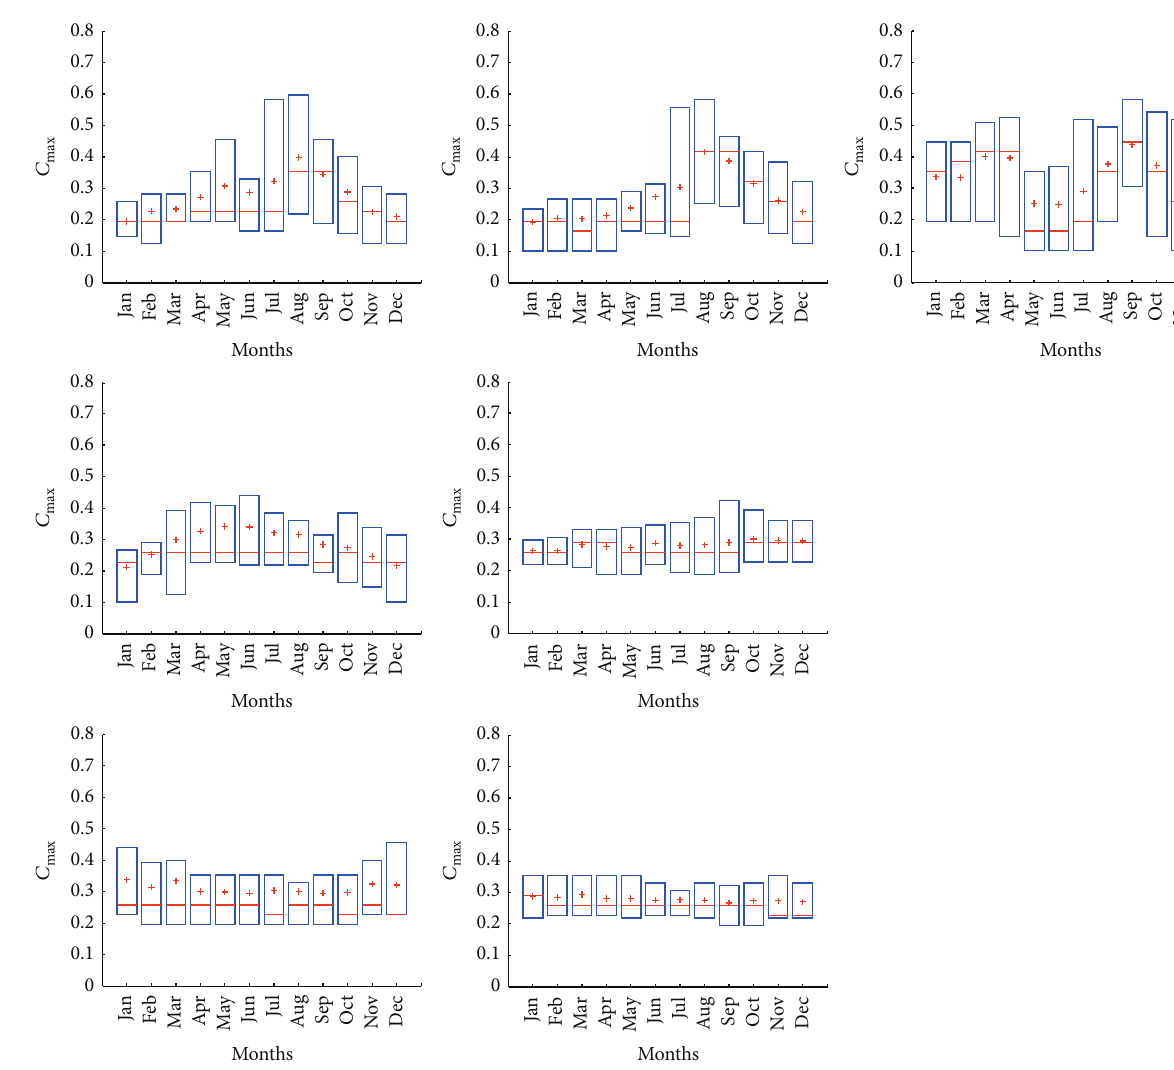
Figure 5: Seasonal variation of parameter 𝐶 max based on the DYNIA for the RMSE (left column), TRMSE (central column), and ROCE (right column) OFs and for 3 (top), 7 (middle), and 13 (bottom)